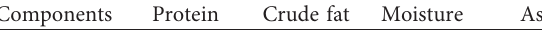
Table 1: Basic composition and content in SPI. Components Protein Crude fat Moisture Ash